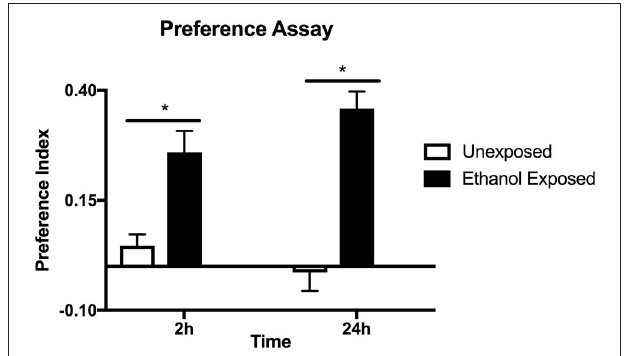
FIGURE 1 | Preference assay for naive or ethanol exposed flies. Preference indices were measured at 2 and 24h in the same batch of flies. Columns represent three independent experiments, each consisting of three assay tubes containing 6–8 flies each. n = 9. Error bars are SEM. Statistical significance was measured by two-way ANOVA with Bonferroni multiple comparisons test. The effect of alcohol treatment was highly significant p < 0.0001 (horizontal line with*). The effect of time was not significant p =